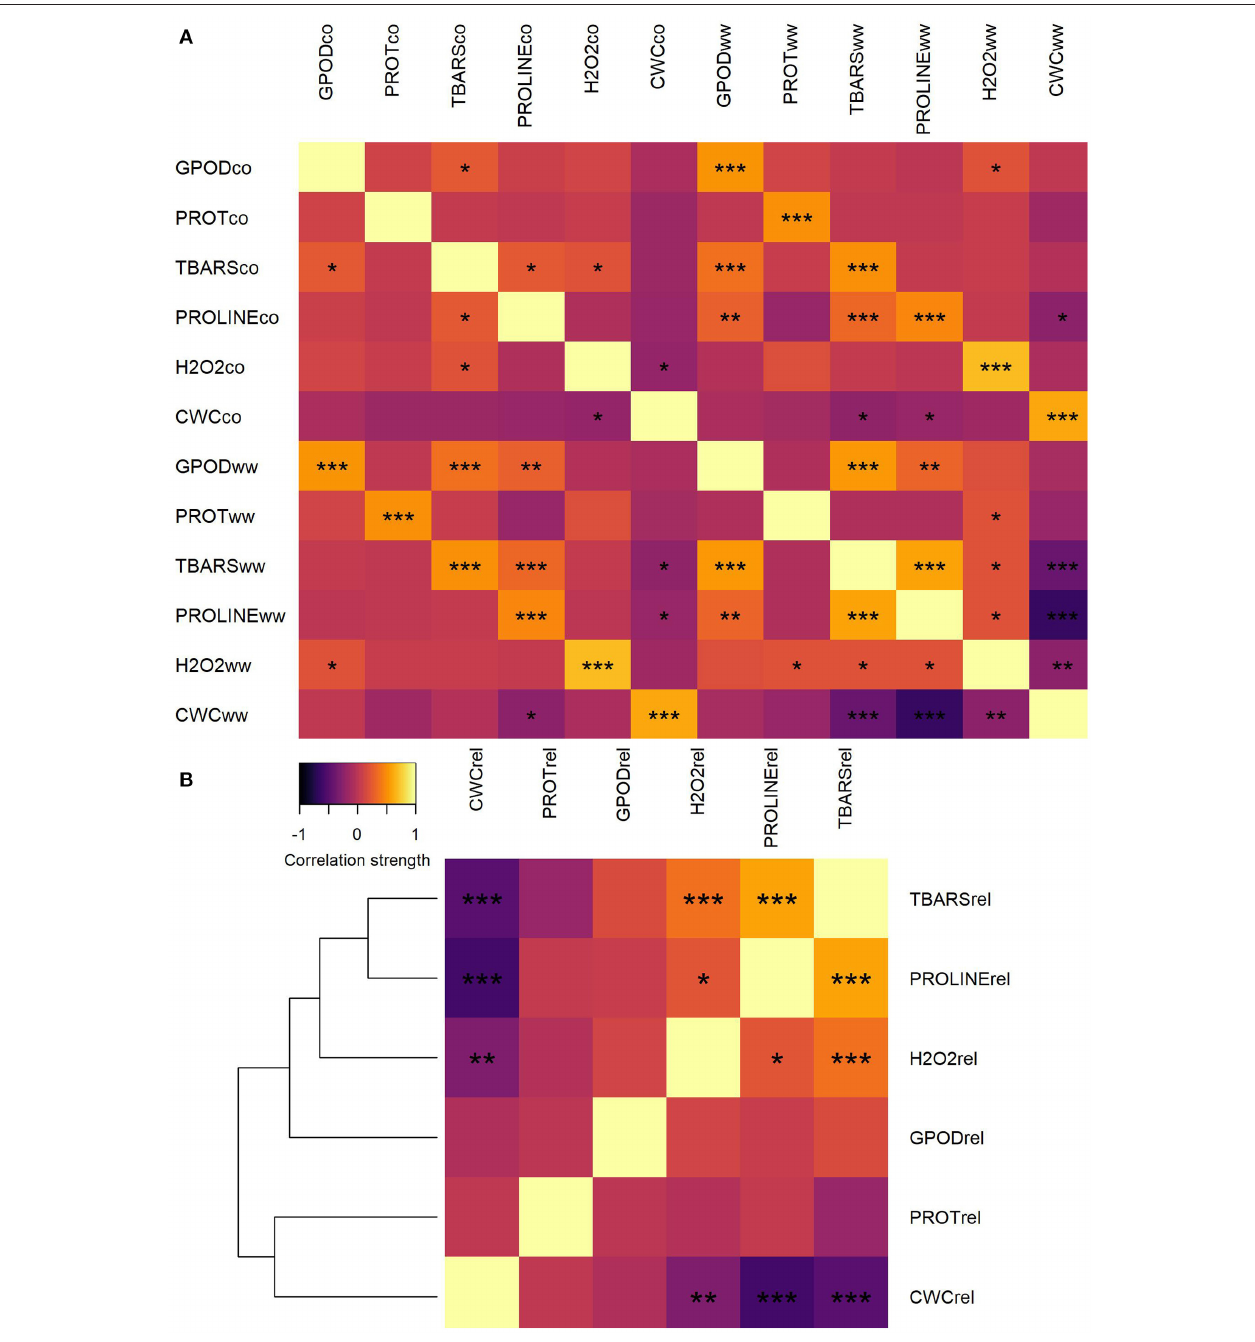
FIGURE 1 | Heatmap of correlations between trait mean values in CO and WW (A) and heatmap and correlation-distance cladogram of correlations between trait fold-change values in WW compared to CO (B) . *, **, and *** represent significance of correlations at α = 0.05, α = 0.01, and α = 0.001 levels, respectively.